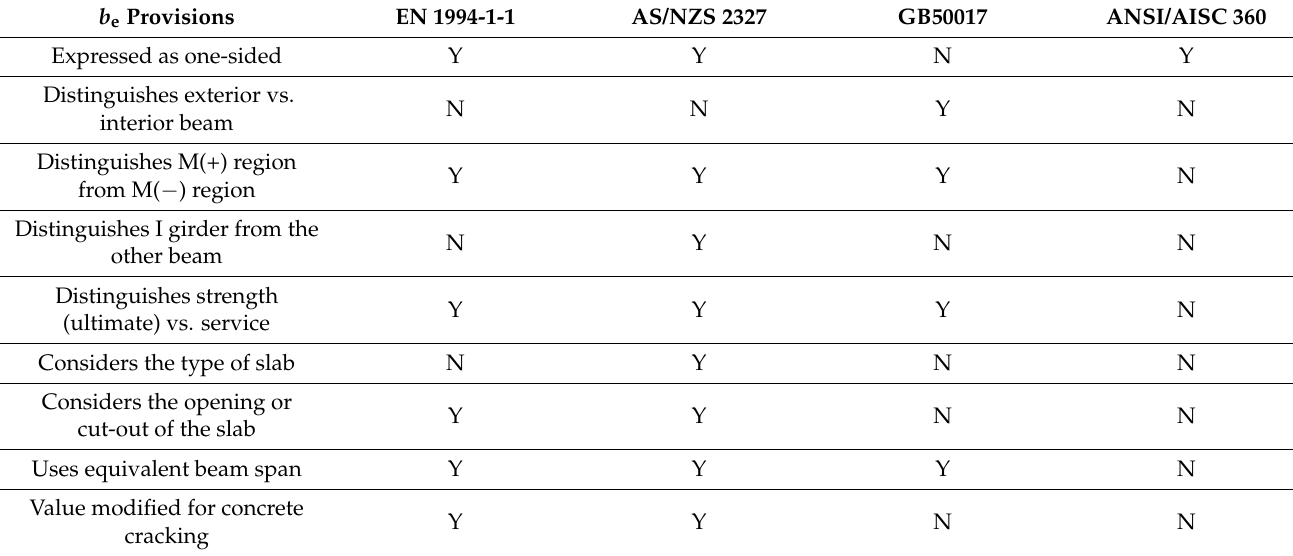
Table 1. Comparison of